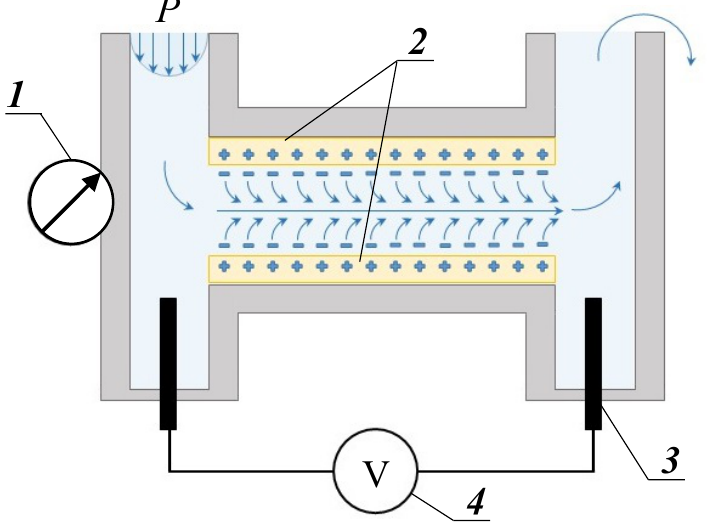
Figure 3. Scheme of the gap cell for measurement of streaming potential: 1—pressure gauge, 2—studied samples, 3—Ag/AgCl electrode, 4—multimeter. Reprinted with permission from Ref. [59]. Copyright © 2017,